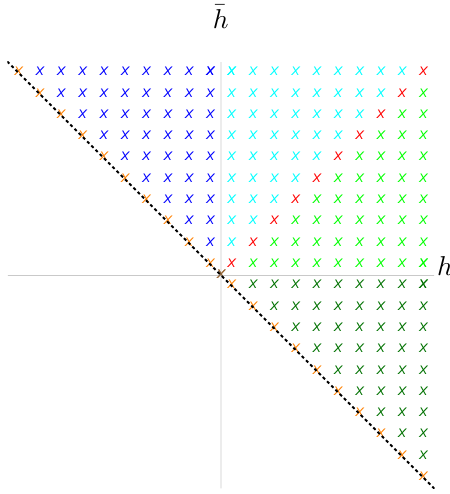
Figure 3 . The spurious poles in the ( h; (cid:22) h )-plane: the light green poles above the h -axis cancel the dark green poles below the h -axis, the light blue poles to the right of the (cid:22) h -axis cancel the dark blue poles to the left of the (cid:22) h -axis, and the orange poles along the line h + (cid:22) h = 0 cancel the red poles along the line h = (cid:22) h . We deform the contour away from the brown pole at h = (cid:22) h =